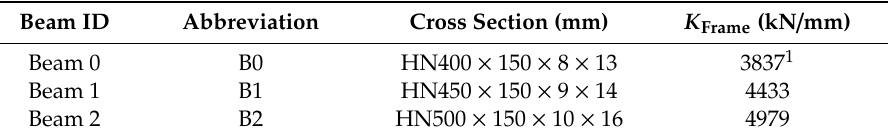
Table 3. Three di ff erent beam sections. Table 3. Three different beam sections.